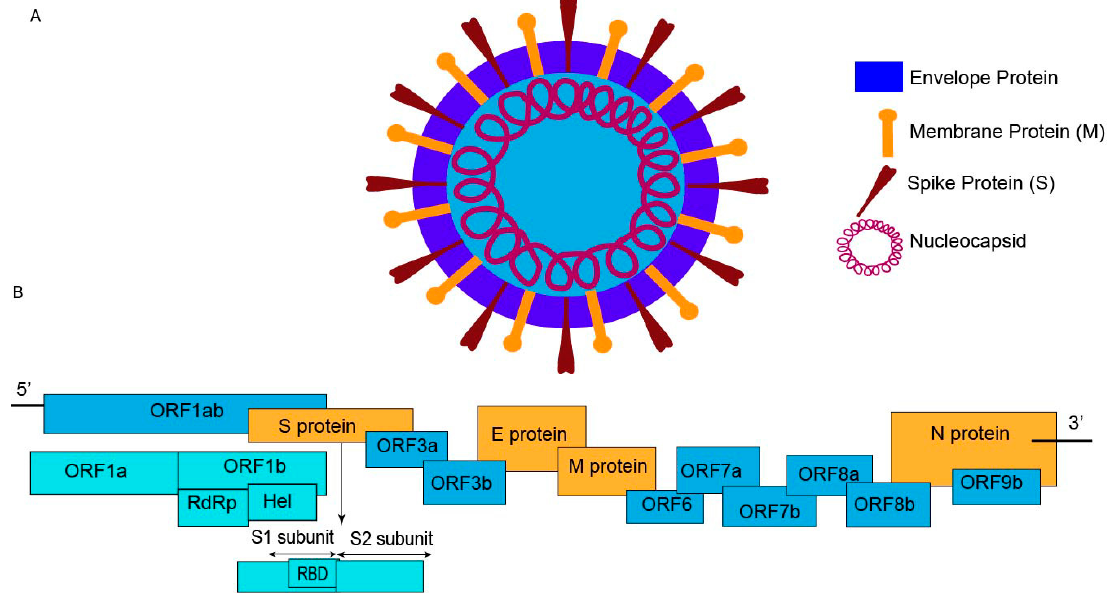
Figure 1. ( A ) The schematic of the SARS-CoV-19 virus displays a spherical structure. It contains surface (S) proteins, envelope (E) proteins, and matrix membrane (M) proteins on the outer surface. The association between single-stranded RNA and nucleocapsid proteins is included in the inner surface. ( B ) The genomic structure of SARS-CoV-2 is shown from the 5 ′ end to the 3 ′ end. The open reading frame (ORF)1ab gene, S gene, and N gene are typically used for nucleic acid testing. Some laboratories and commercial companies target RdRp and Hel enzymes. S proteins and N proteins are typical targets for serological COVID-19